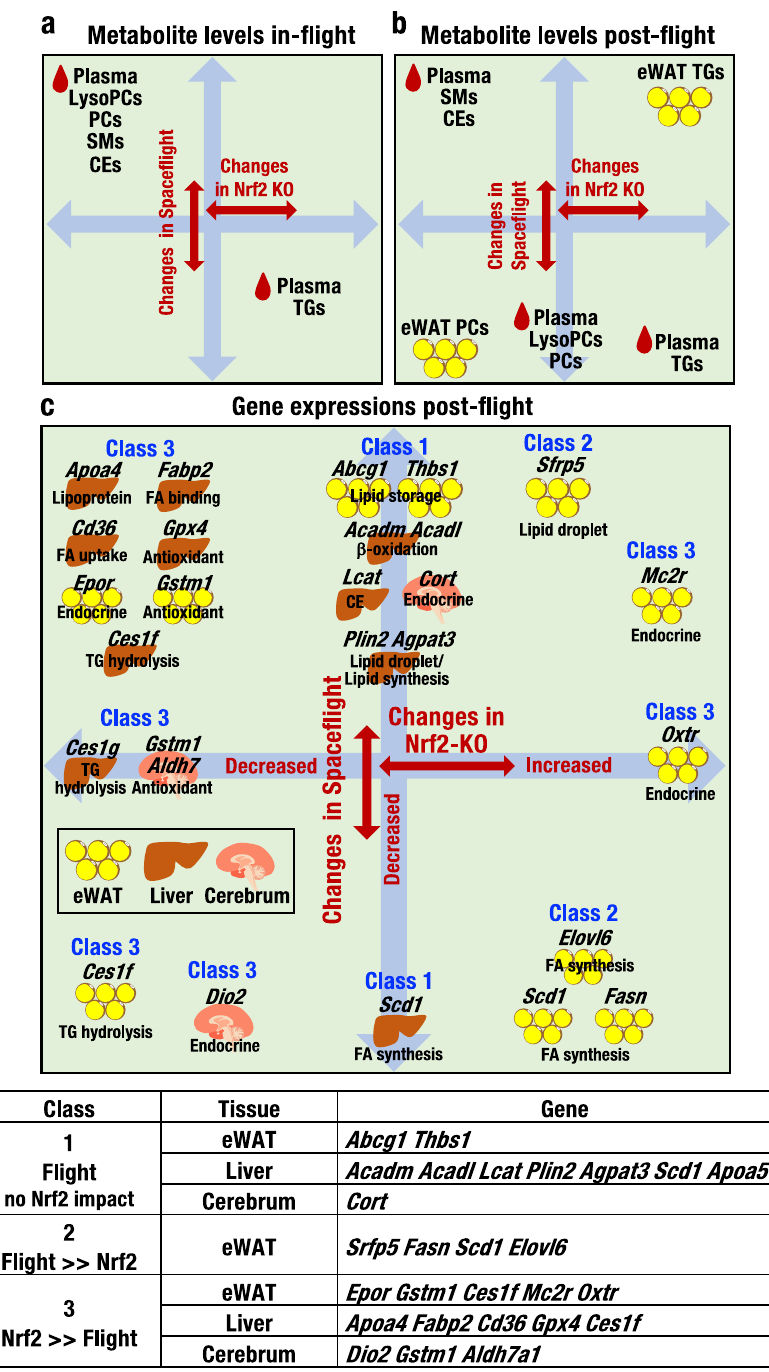
Fig. 8 Metabolic response and changes in gene expression during and after space fl ight. a – c Schematic representations of metabolic responses during ( a ) and after ( b ) space fl ight. Vertical arrows denote changes in metabolite levels in the plasma and eWAT during ( a ) or after ( b ) space fl ight. Horizontal arrows denote these changes in Nrf2 KO mice. Schematic representations of changes in gene expression in the eWAT, liver and cerebrum after space fl ight are also provided ( c ). Vertical arrows denote changes in gene expression levels in the eWAT, liver and cerebrum after space fl ight ( c ). Horizontal arrows denote these changes in Nrf2 KO mice. d Classes of genes in the eWAT, liver and cerebrum. Class 1 includes genes with substantially altered expression in response to space fl ight that are not in fl uenced by the Nrf2 KO genotype; Class 2 includes genes whose expression is affected by Nrf2 KO, but the changes are overridden by space fl ight; and Class 3 includes genes that are modulated by space fl ight, but the changes are overridden by Nrf2